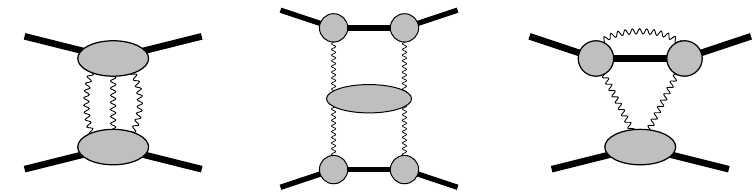
Figure 6. Spanning set of unitarity cuts relevant for the soft region at O ( G 3 ) .